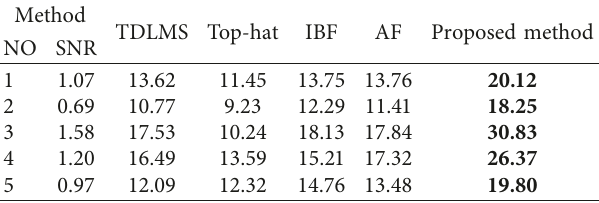
Table 2: Contrast gain results of different algorithms. Method